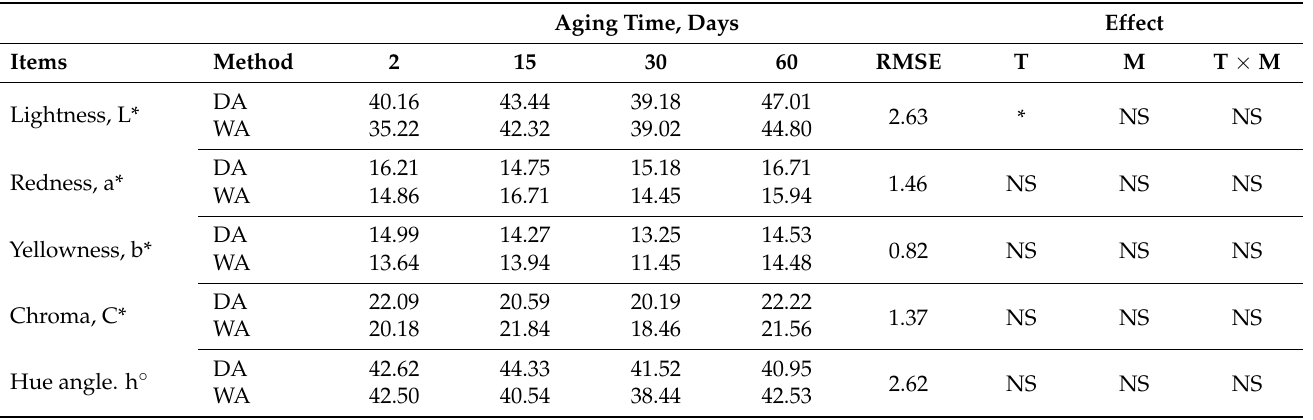
Table 3. Changes in the meat color attributed as a function of the aging method and time in Charolais meat cuts ( Longissimus dorsi (LD) and Semitendinosus (ST)) aged by different methods (dry-aging (DA) and wet-aging (WA)) for 60 days.